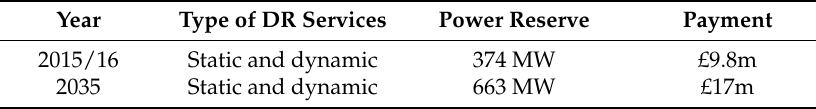
Table 4. An executive summary of the values of DR services in 2015/16 in the UK, as compared to their values in 2035 using the proposed DR controller.